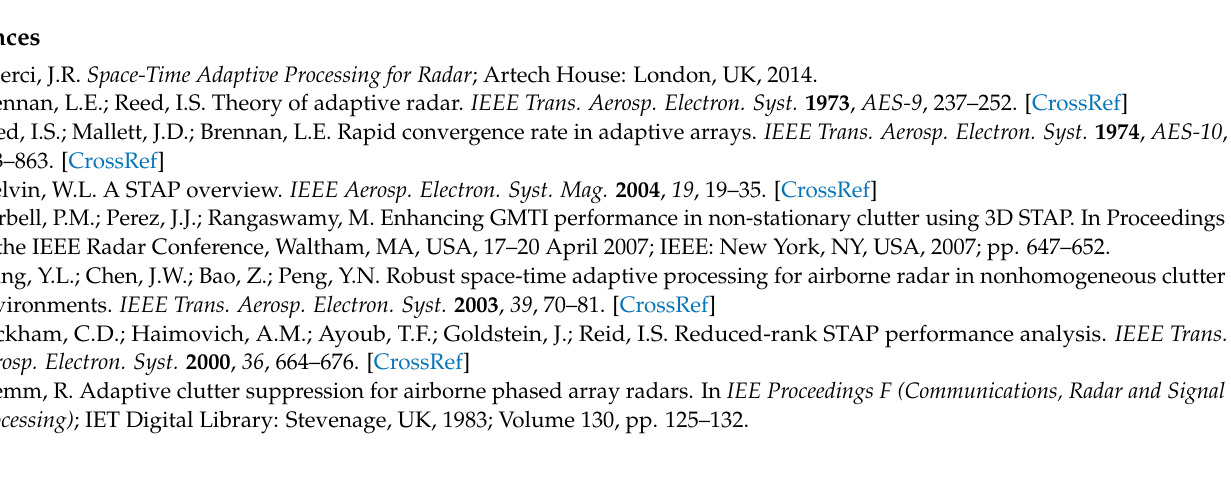
Figure 16. Low-accuracy and high-accuracy mapping results of CycleGAN with the low-accuracy clutter spectrum dataset obtained by ( a ) Fourier transform, ( b ) MVDR algorithm, ( c ) MMV-ADMM algorithm, and ( d ) the trained